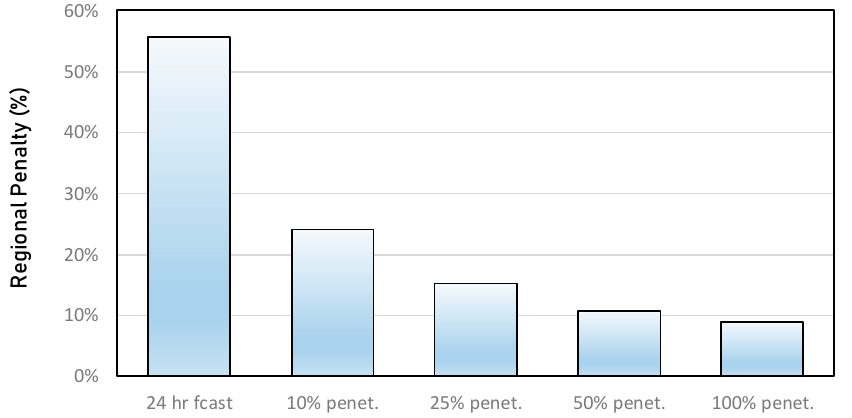
Figure 12. Regional penalty as a function of penetration and firmness requirements from 24-h-ahead forecasts with firm power generation.